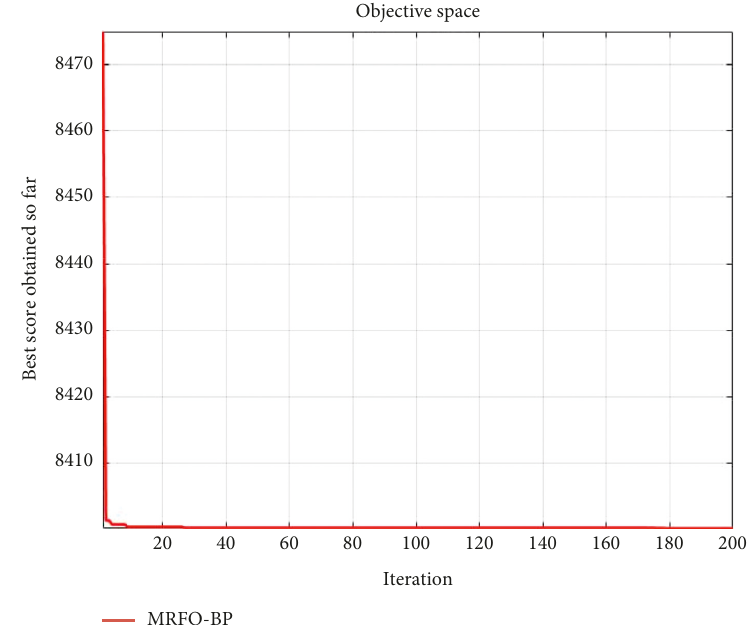
Figure 13: Historical optimal position curve of the